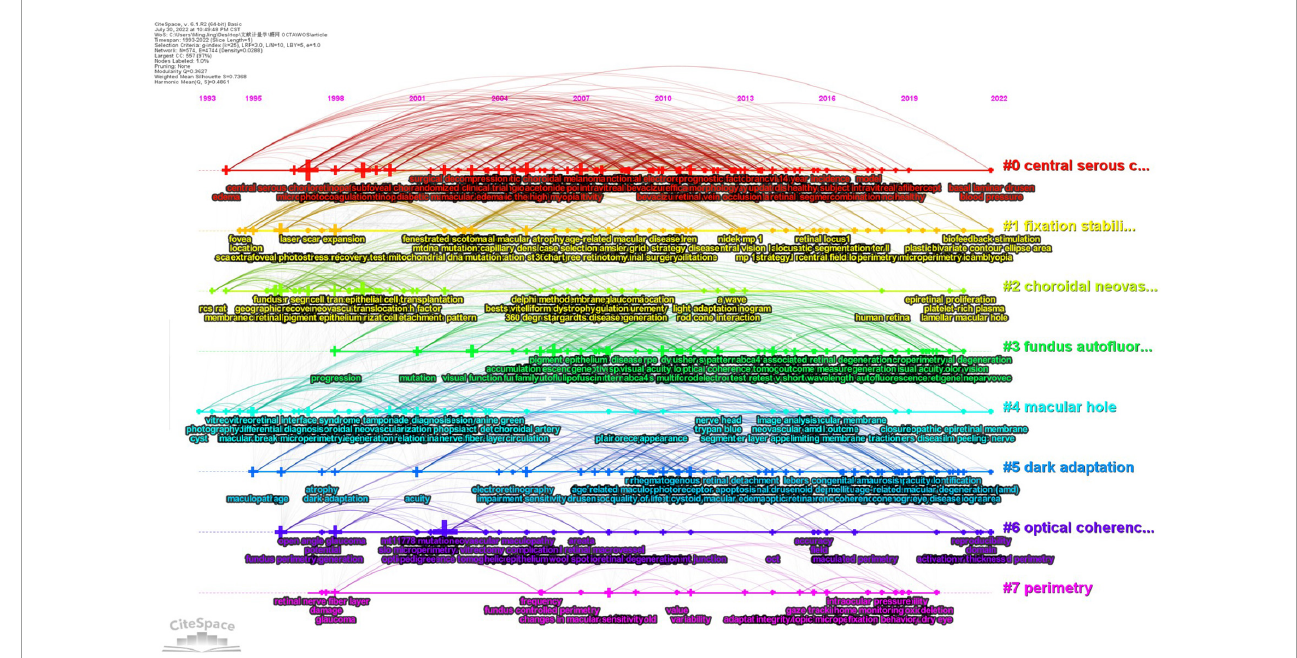
FIGURE12 Keyword evolution by timeline. Seven core keywords were arranged as forms of timelines vertically. #0: central serous chorioretinopathy; #1: fixation stability; #2: choroidal neovascularization; #3: fundus autofluorescence; #4: macular hole; #5: dark adaption; #6: optical coherence tomography; #7: perimetry. Each timeline covered a series of keywords.